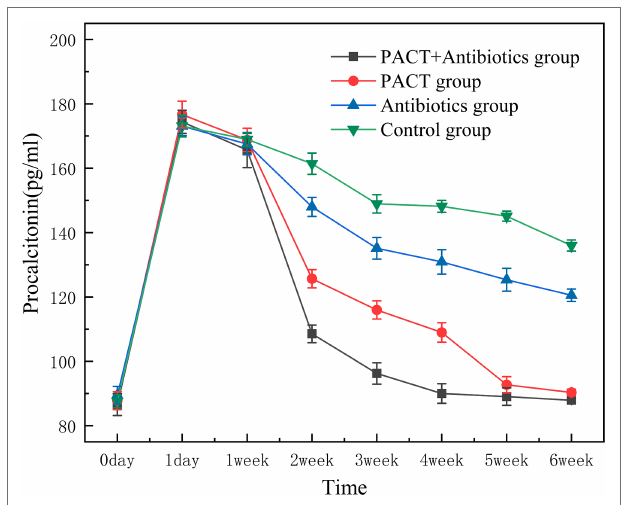
FIGURE 6 | Detection results of serum